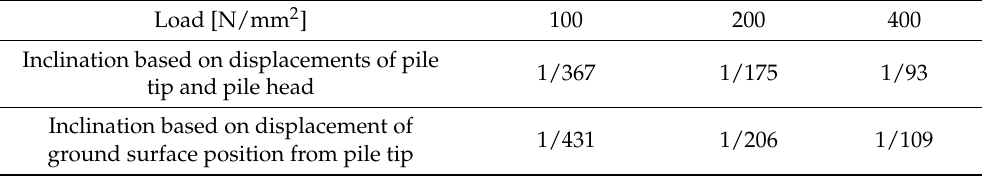
Figure 11. Comparison of displacements in x -axis direction when loads acting on pile head are 100, 200, and 400 N/mm 2 , respectively. Table 2. Relationship between acting loads on newly built pile foundation and their